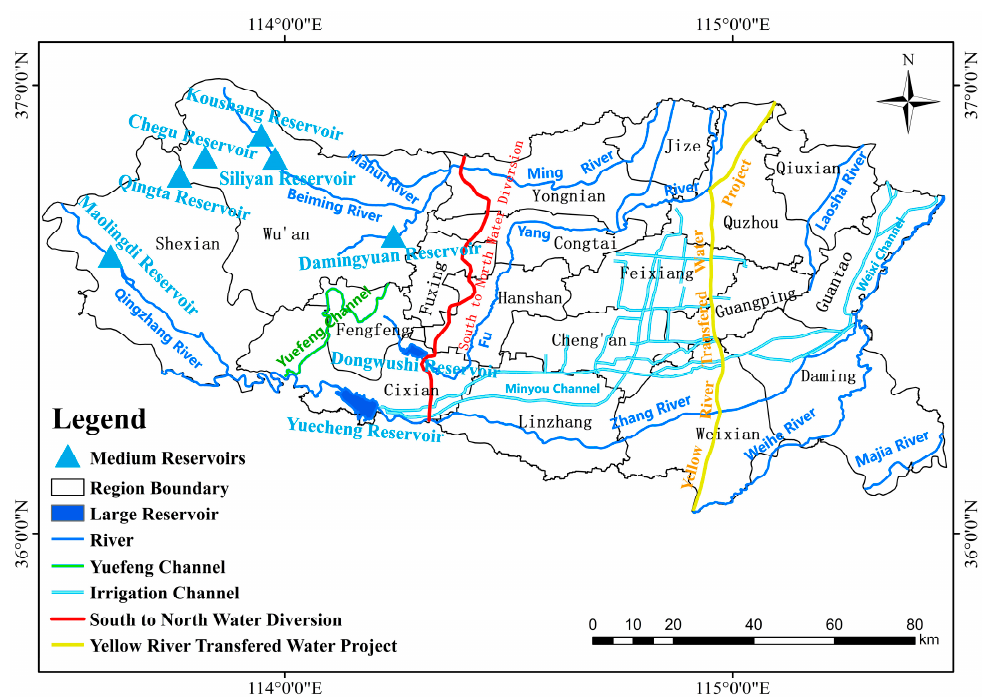
Figure 1. Distribution of water systems, water conservancy projects, and administrative divisions in Handan.